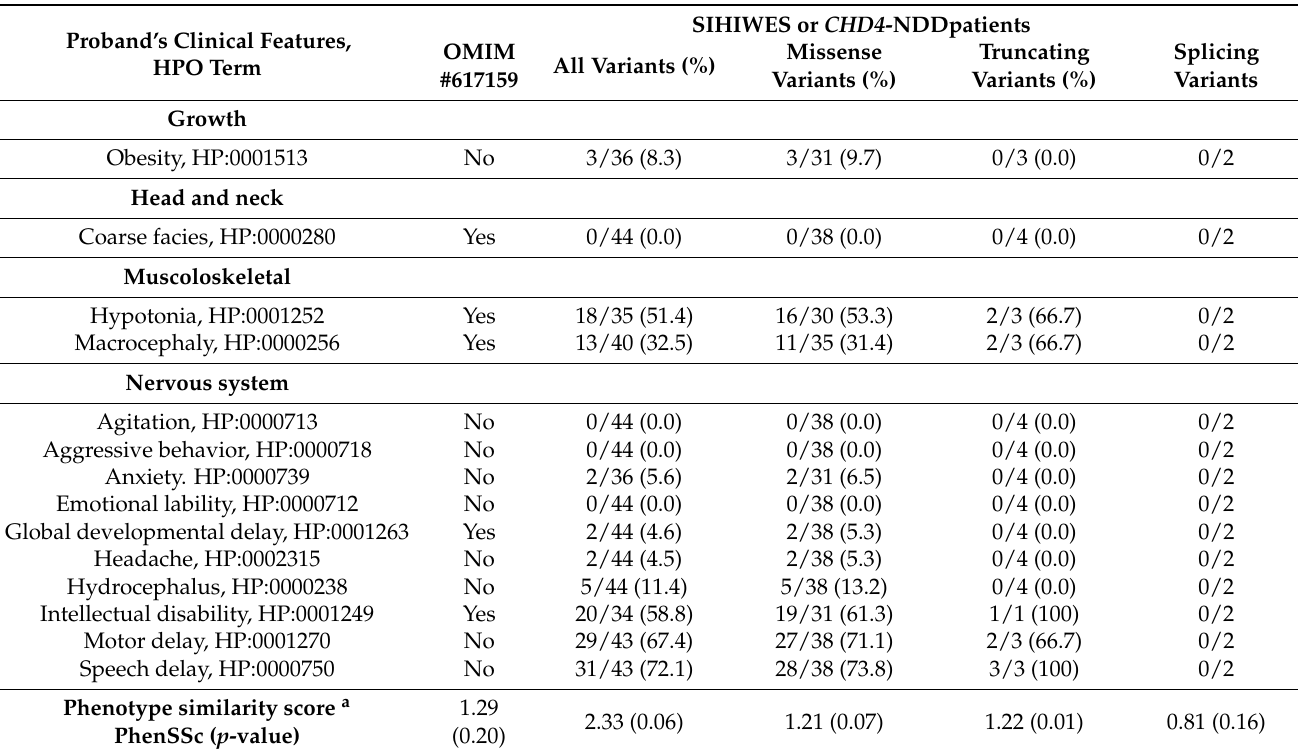
Table 1. Comparison of the proband’s (DGRC0021) clinical features with those reported for SIHIWES or CHD4 -NDD patients, subdivided according to the pathogenic variant type and the corresponding phenotype similarity